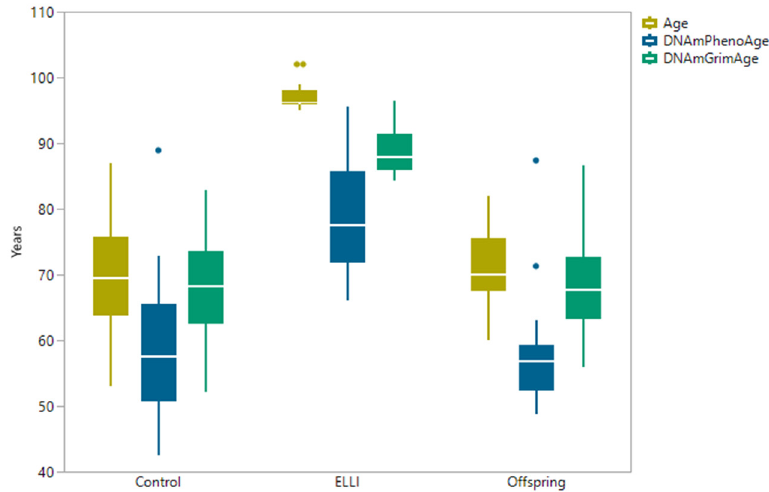
Figure 2. Comparison of actual age and two age clocks. DNAmGrimAge and DNAmPhenoAge calculated by applying methylation beta values to DNAm online tool [37]. N control = 28, N ELLI = 24, and N offspring = 18.